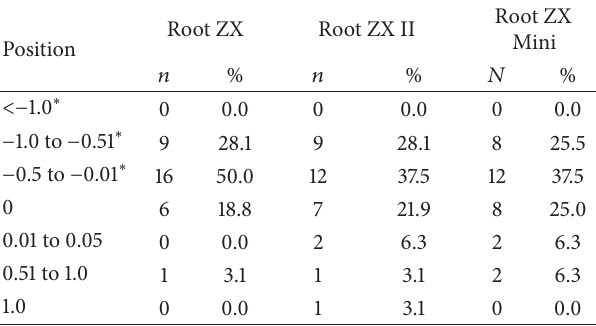
∗ Negative values indicate that the endodontic file is positioned inside the root